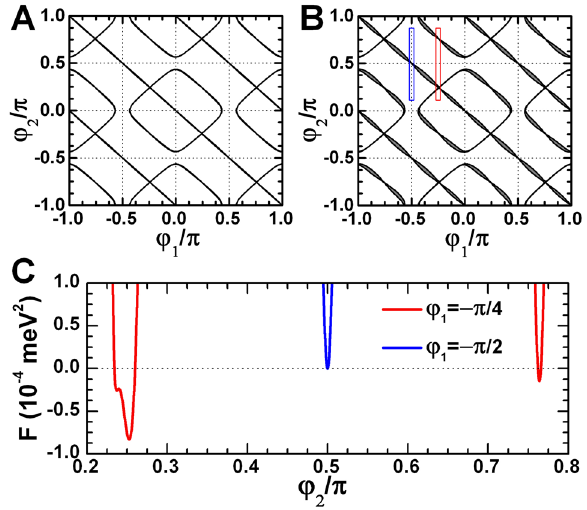
Figure 5. Topological corner states in (013)-oriented prototype QWs. ( A , B ) The phase diagram for the presence (grey region) and absence (white region) of 0D topological corner states in the three-layer InAs/ GaInSb ( A ) and double HgTe/CdHgTe QWs ( B ) as a function of the two edge orientations. The vertical and horizontal thin dotted lines represent the angles when the edges of 2D system coincide with [100] and crystallographic planes. ( C ) The function F (ϕ 1 , ϕ 2 ) the existence condition of Eq. (26) at β 1 dotted line marks the zero